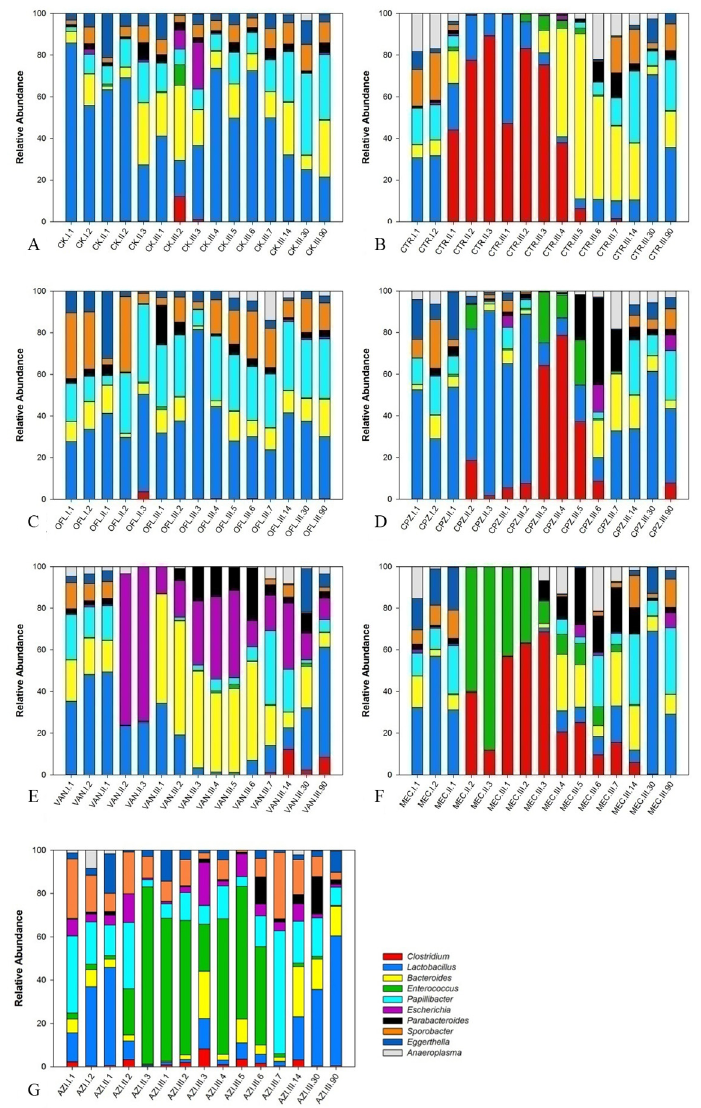
Fig 4. Microbial structure at the genus level for different antibiotic groups. A. CK; B. CTR; C. OFL; D. CPZ; E. VAN;F. MEC; G.